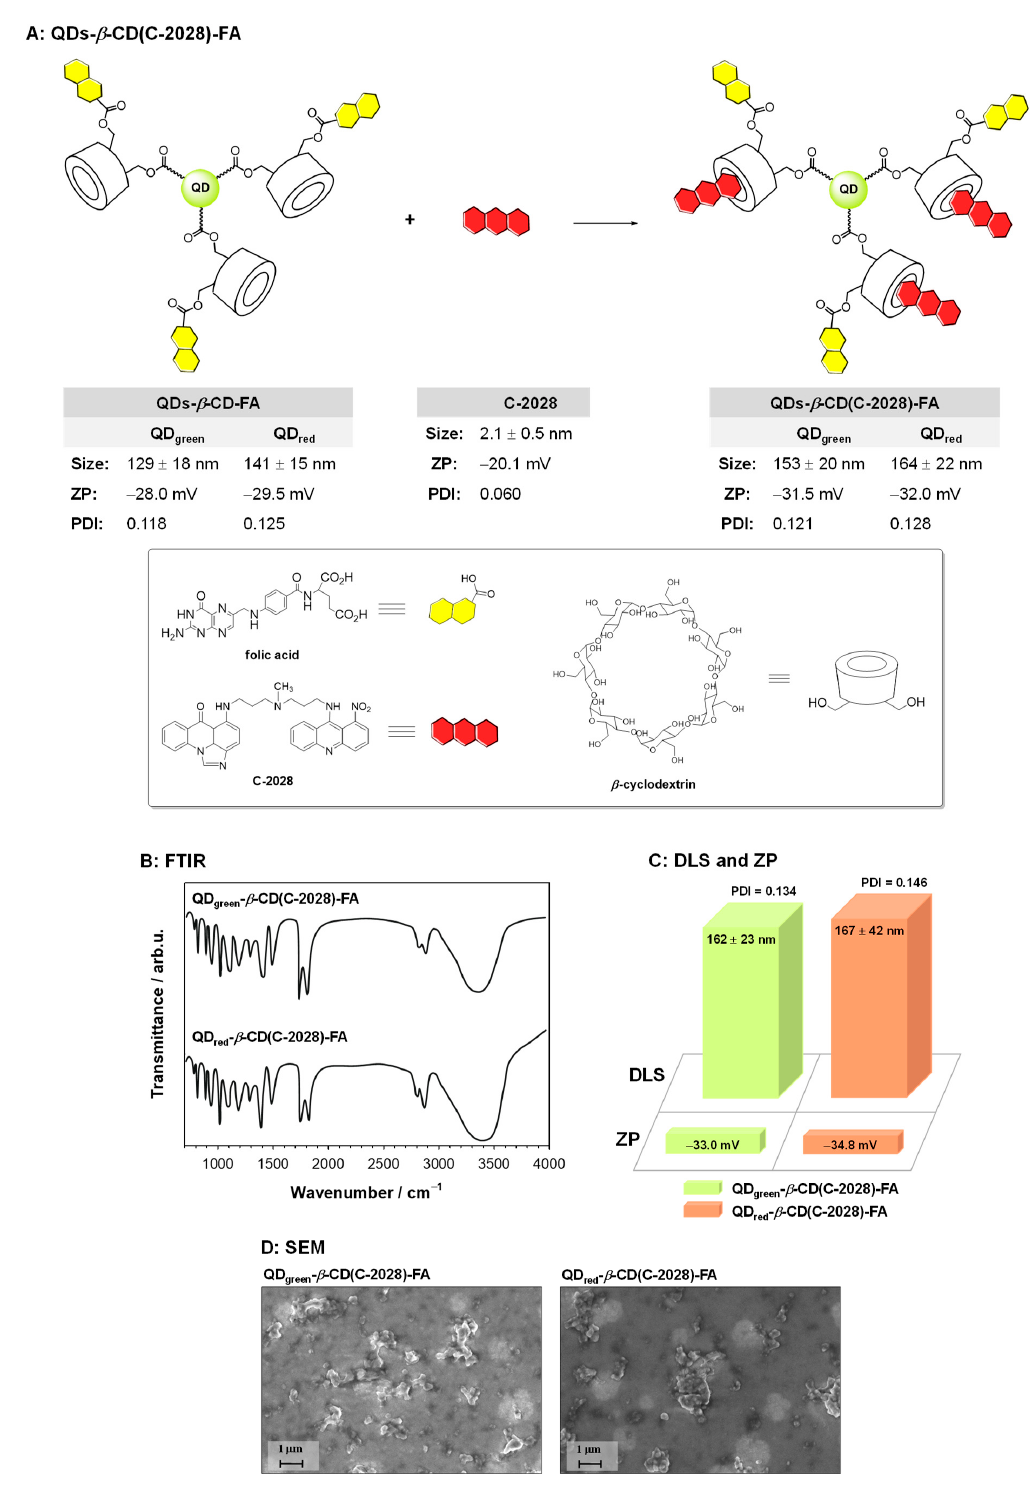
Figure 1. Scheme of QDs- β -CD(C-2028)-FA nanoconjugate synthesis and values of the mean hydrodynamic diameter, zeta potential (ZP), and polydispersity index (PDI) were determined in 0.02 M PBS (pH 7.4) ( A ). FTIR spectra ( B ), DLS and ZP ( C ), and SEM images ( D ) of QDs- β -CD(C-2028)- FA